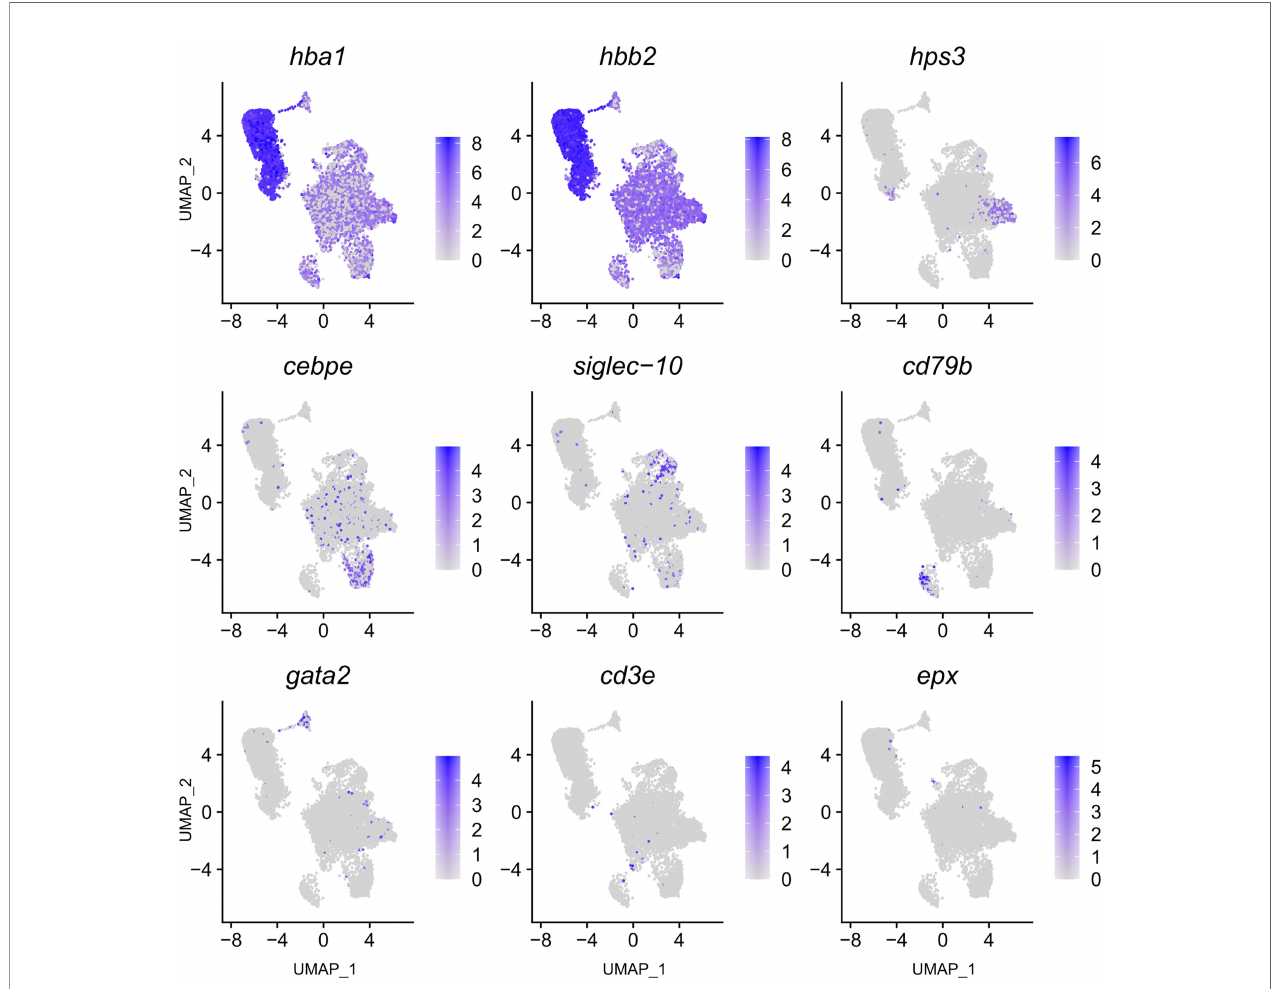
FIGURE 3 | Feature plot highlighting Syngnathus typhle blood and head kidney cells expressing selected genes characterizing selected immune cell clusters within Uniform manifold approximation projection (UMAP). Increased cell color intensity indicates increased gene